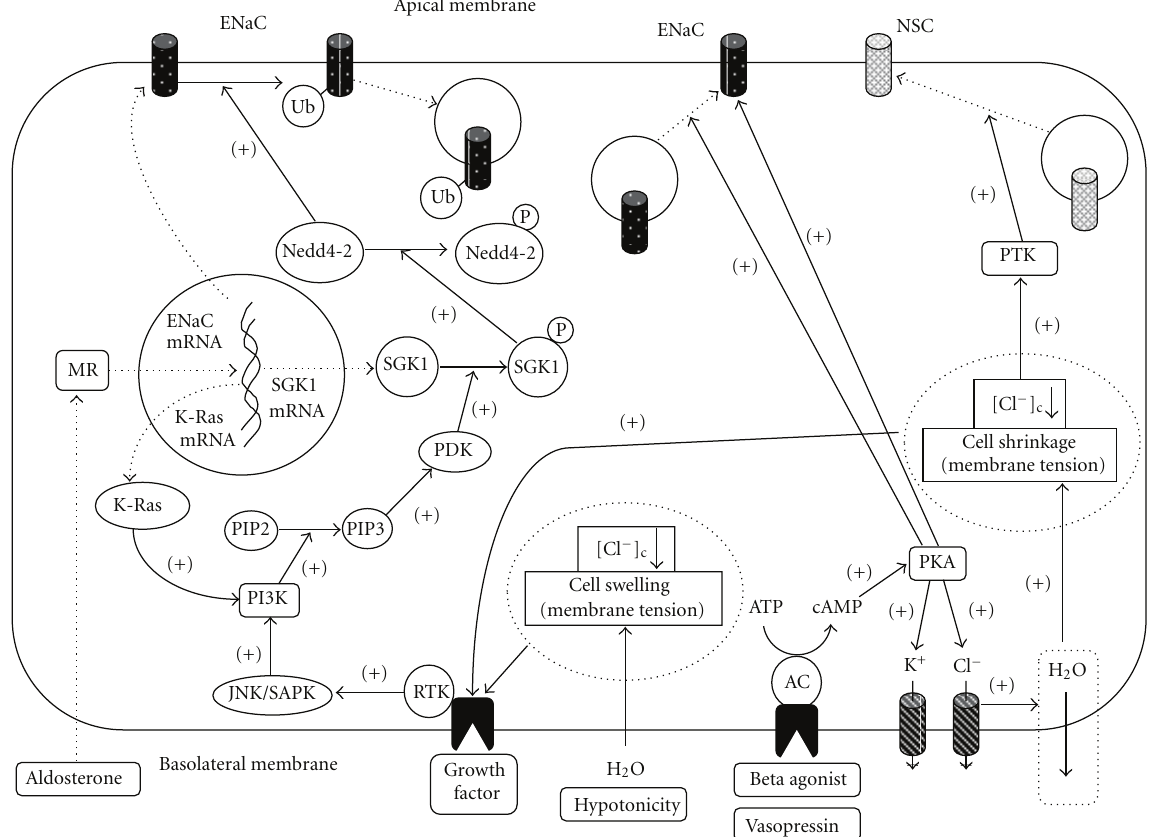
Figure 1: Regulatory pathways of ENaC and nonselective (NSC) channel in renal and fetal alveolar type II epithelial cells. Arrow lines without (+) mean the conversion to a form at the end point of arrow form a form at the starting point of arrow. Arrow lines with (+) mean that the compound at the starting point of arrow; (1) stimulates the conversion indicated by an arrow without (+), (2) activates an enzyme, or (3) induces the indicated condition. Arrowheads with dashed lines mean that the compound at the start point of the arrowhead with dashed line moves to the end point of the arrowhead with dashed line (translocation). [Cl − ] is the concentration of cytosolic Cl − . Circled P means a phosphorylated